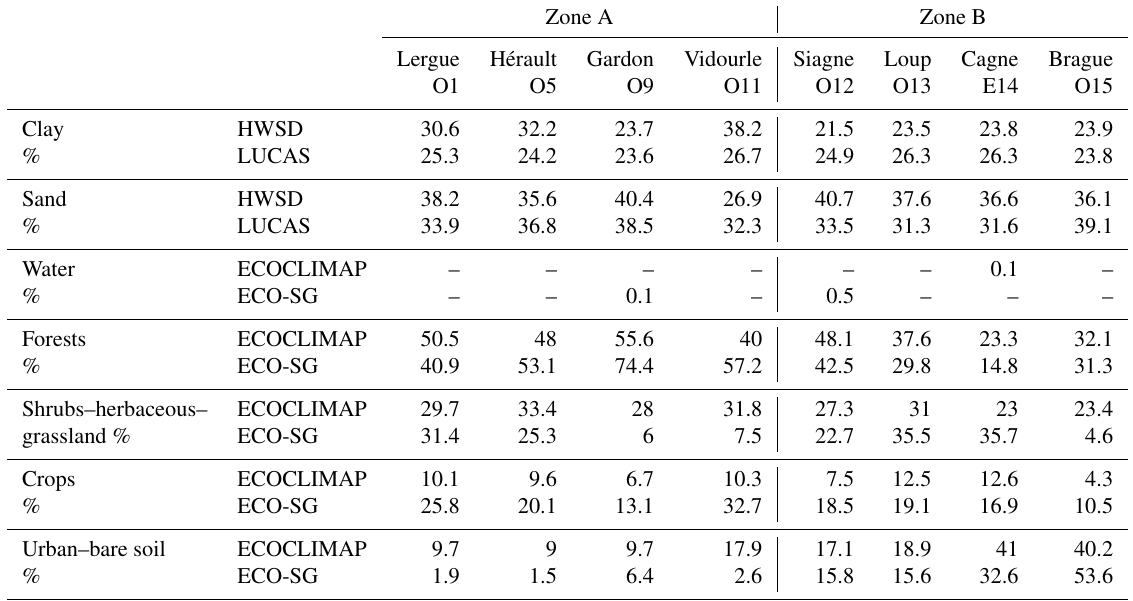
Table 3. Mean soil texture fractions per watershed from the HWSD and LUCAS topsoils and fraction of the land use types from ECOCLIMAP-II and ECO-SG.